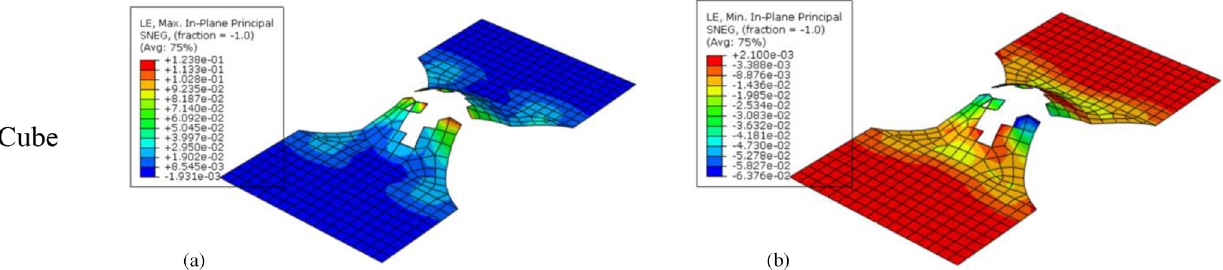
Fig. 7. (a) Maximum in-plane principle strain under uniaxial stretching. (b) Minimum in-plane principle strain under uniaxial